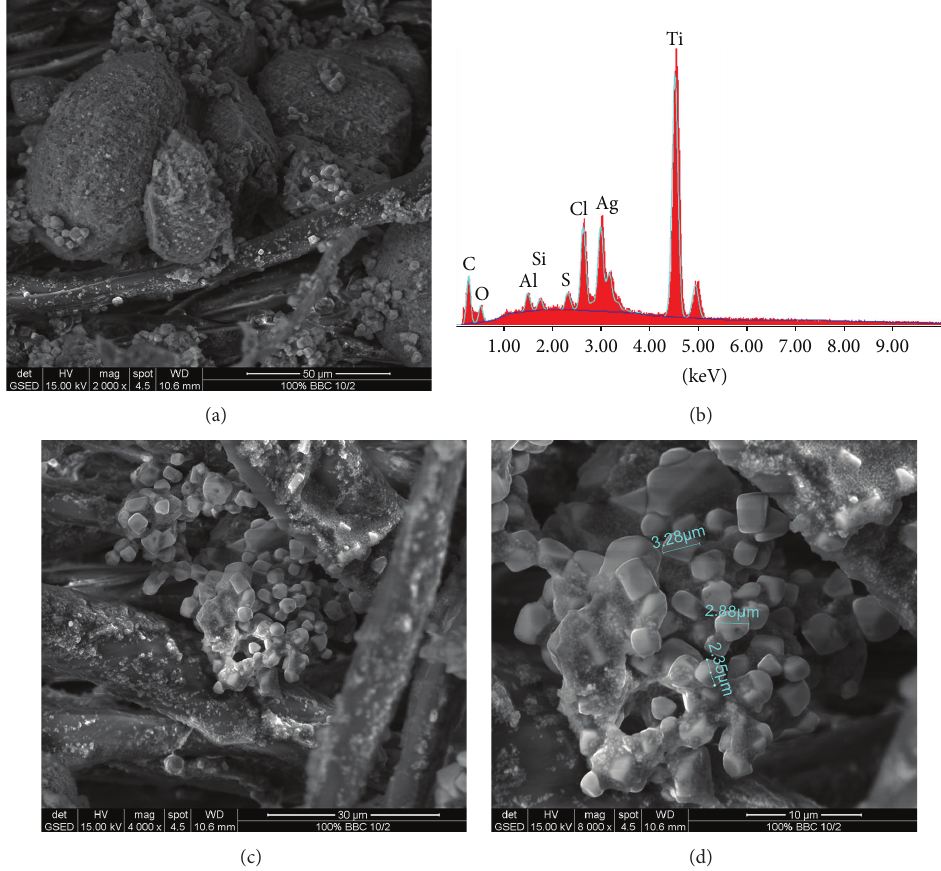
Figure 7: SEM and EDAX images for sample IIs (antimicrobial finished plasma functionalized type II cotton): (a) SEM image for sample IIs at resolution × 2000, (b) EDAX image for sample IIs, (c) SEM image for sample IIs at resolution × 4000, and (d) SEM image for sample IIs at resolution ×